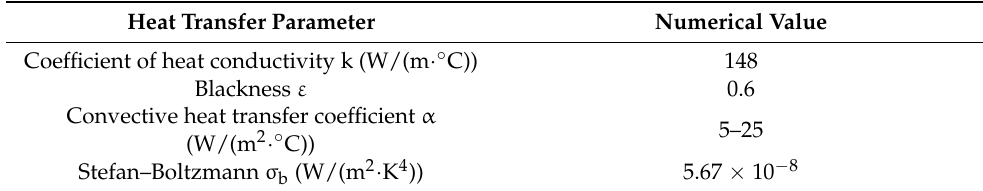
Table 1. Parameters of silicon at the conventional scale.